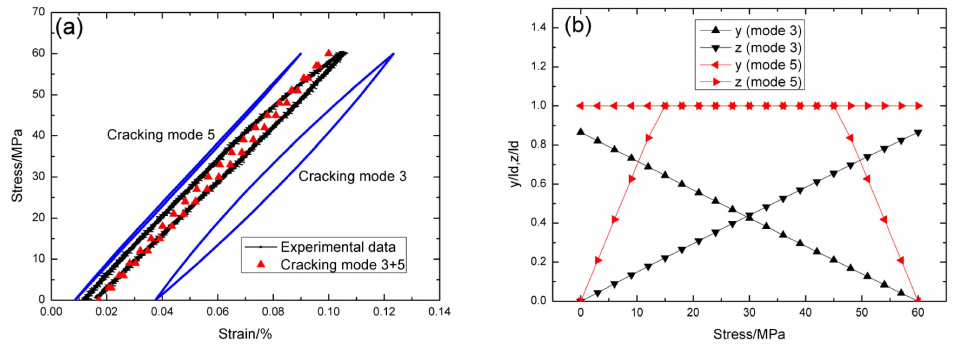
Figure 3. ( a ) The theoretical and experimental hysteresis loops; and ( b ) the interface slip lengths, i.e. , y / l d and z / l d , of matrix cracking mode 3 and mode 5 of cross-ply C/SiC composite when σ max = 60 MPa.